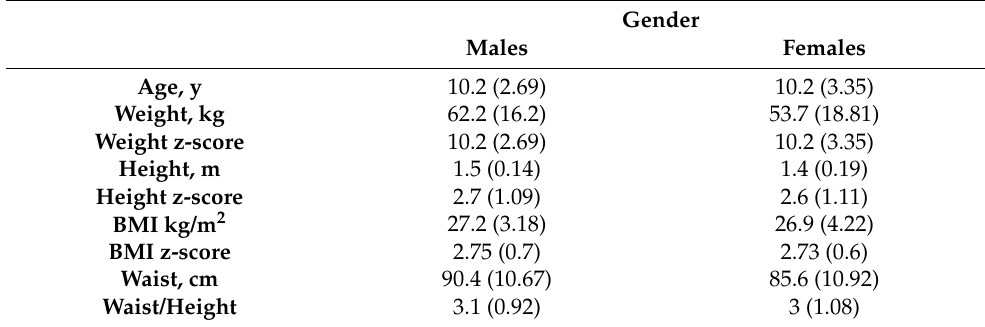
Table 1. Clinical and anthropometric characteristics of the subjects according to gender (data are expressed as the mean